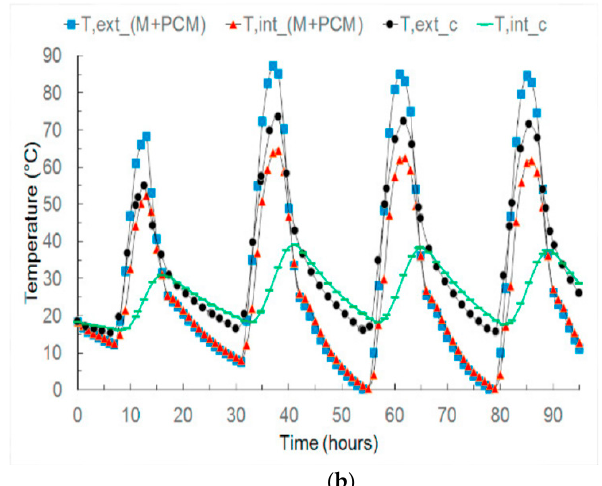
Figure 4. ( a ) The schematic of a full-scale experimental room with PCM; ( b ) Temperature comparison of ordinary wall room and PCM room. Reproduced with permission from [80]. Elsevier: Energy Procedia, copyright 2017.